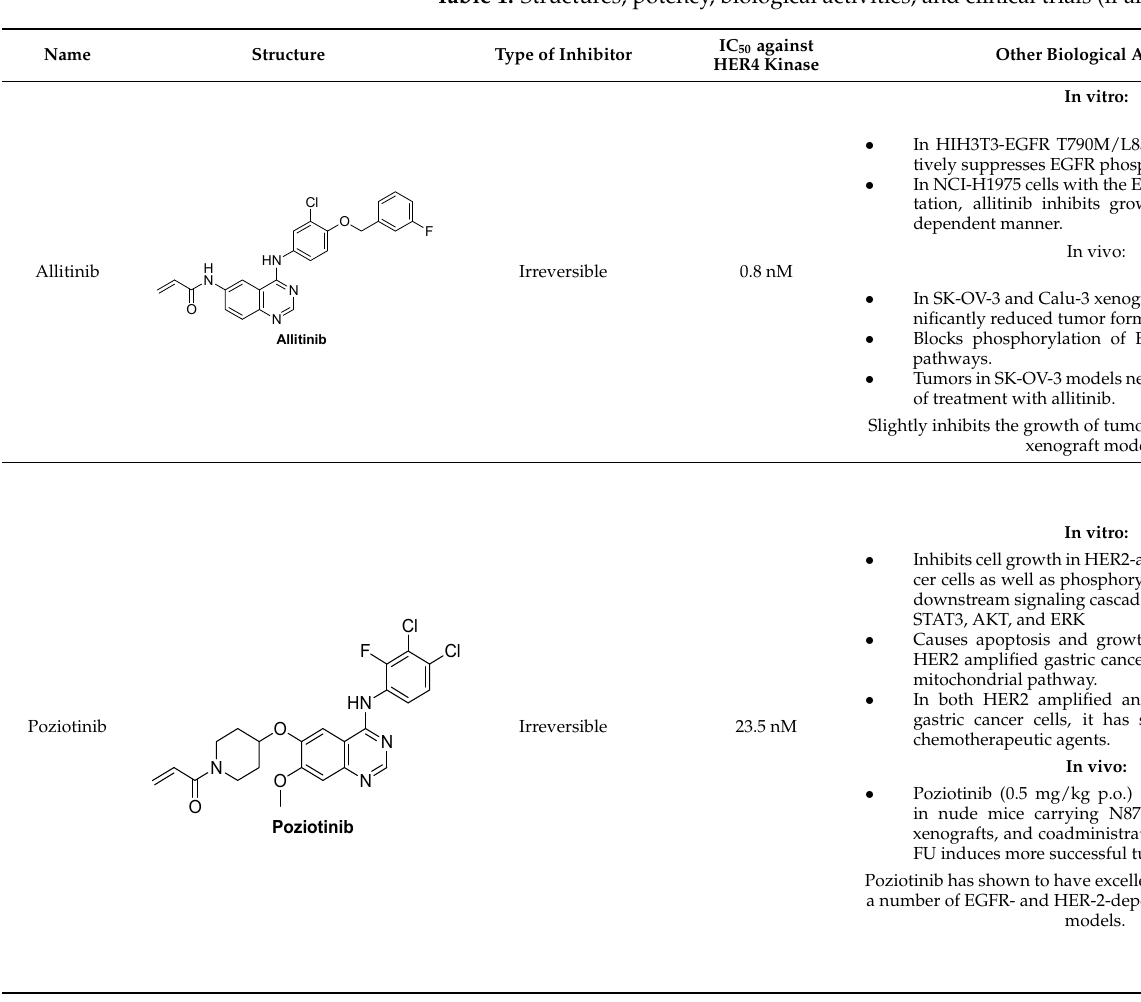
Table 1. Structures, potency, biological activities, and clinical trials (if any) of the reported HER4